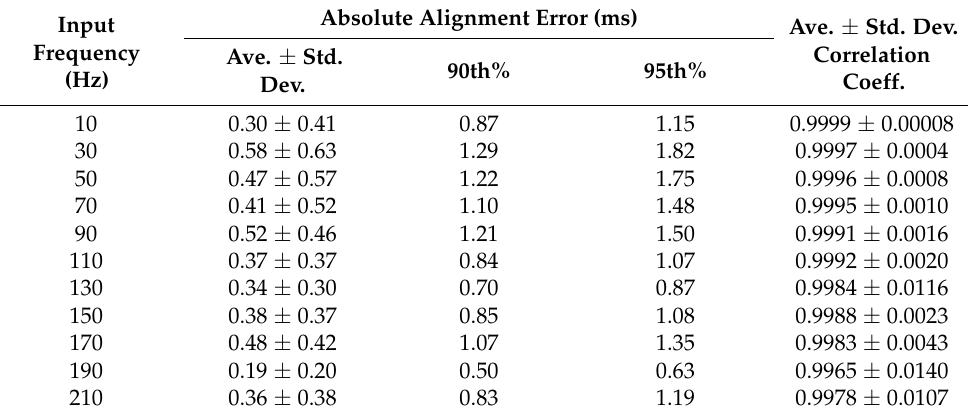
Table 2. Summary of absolute alignment errors and correlation coefficients of linear interpolation data alignment (LIDA) algorithm as a function of input sine wave